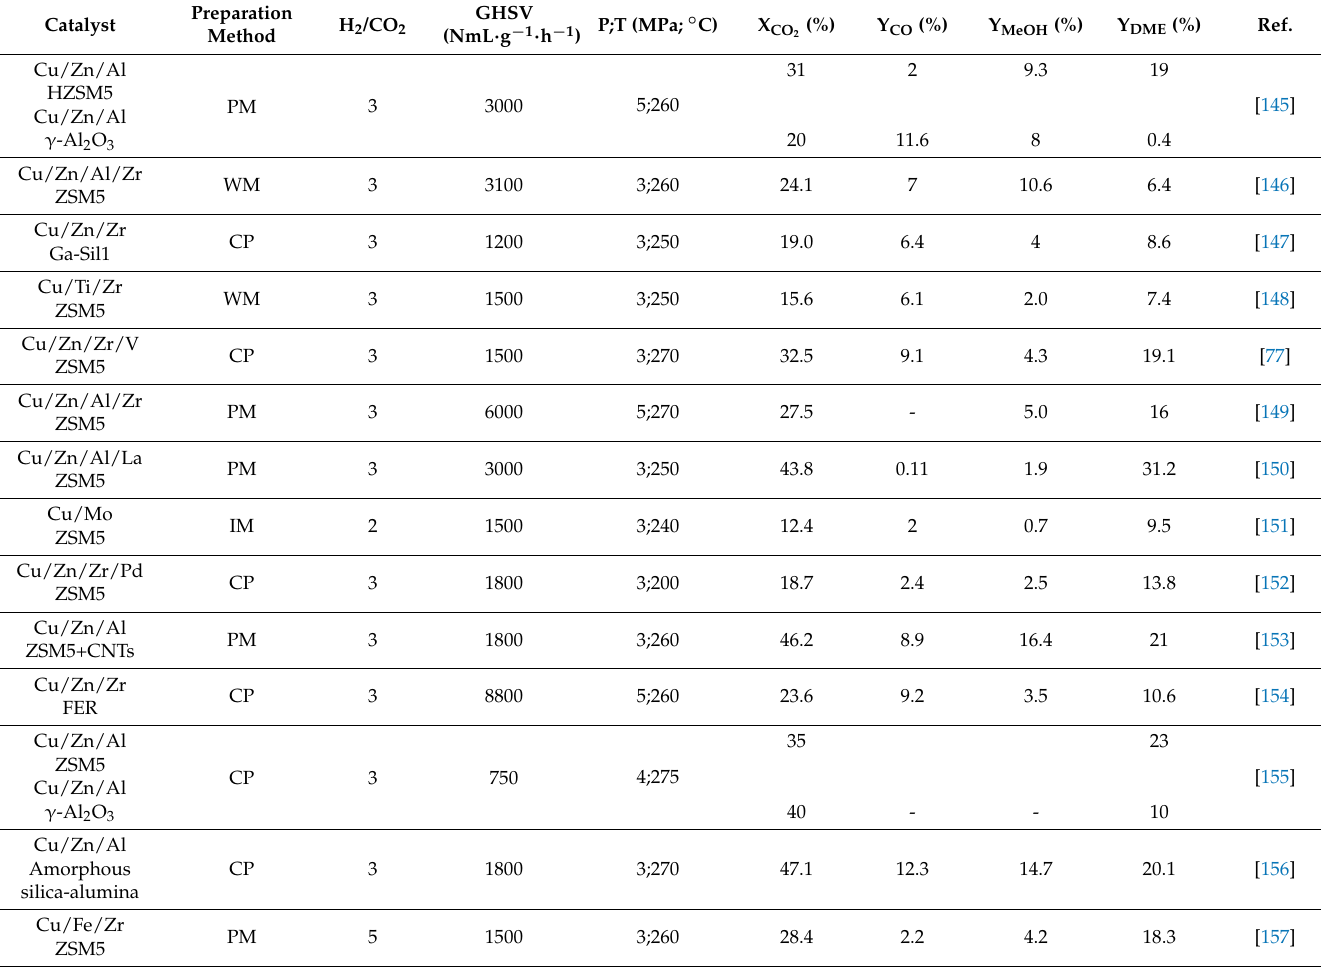
Table 4. Recent investigated catalysts for one-pot CO 2 -to-DME process. PM: physical mixing; WM: wet mixing; CP: co-precipitation; IM: impregnation; GHSV: Gas Hourly Space Velocity; P: reaction pressure; T: reaction temperature; X CO